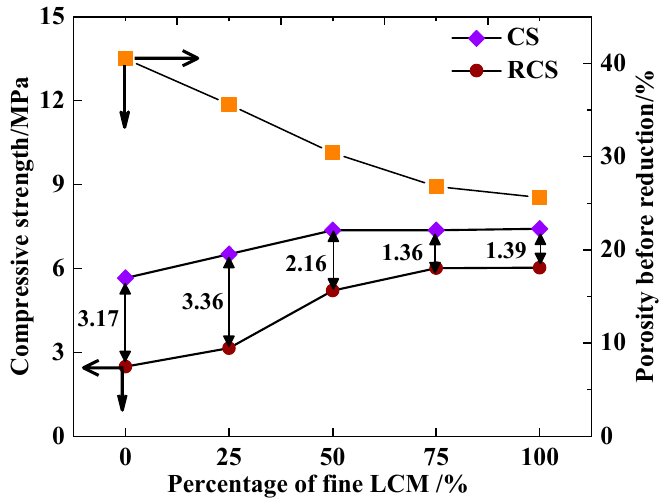
Figure 6. Effects of fine LCM on CS, RCS and porosity with Fe 2 O 3 -MgO.